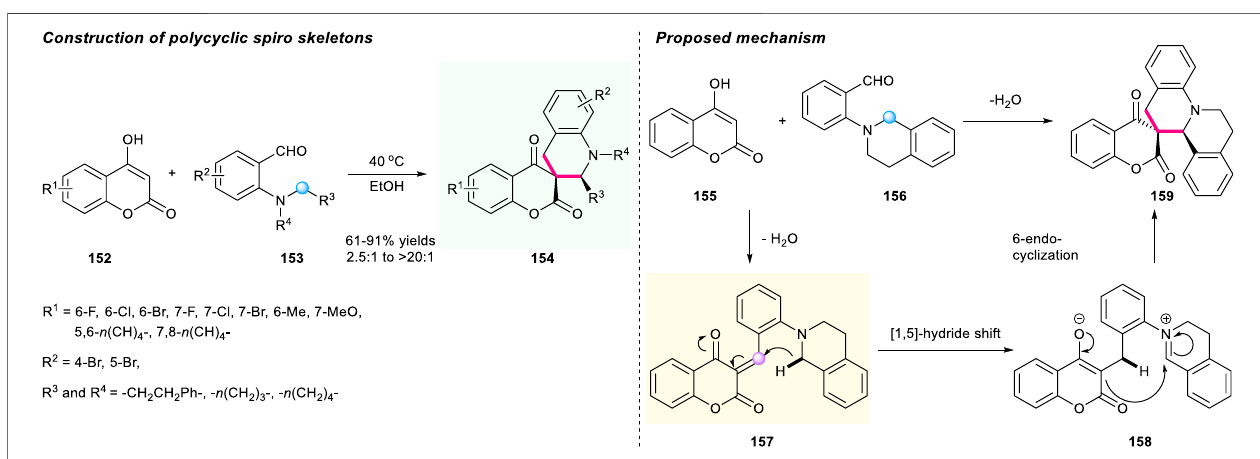
SCHEME 16 | [1,5]-Hydride shift reaction toward spirocyclic tetrahydroquinolines bearing chromanone moieties.